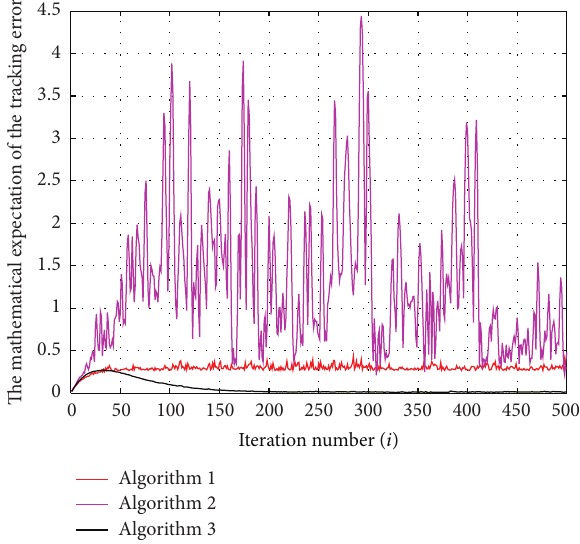
Figure 2: The max tracking error versus iteration with 5% packet dropout.